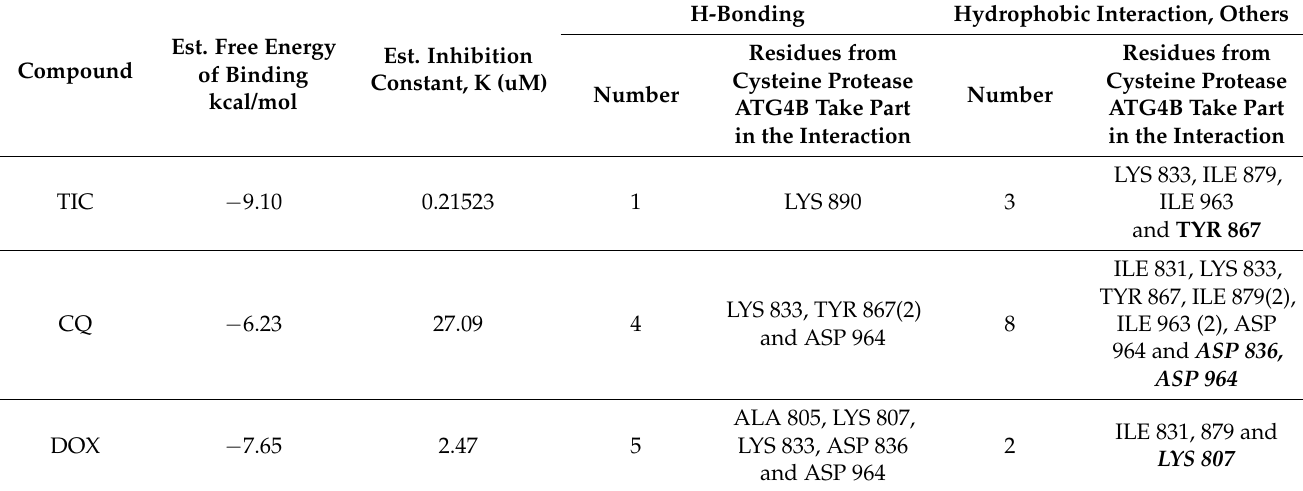
Table 3. Results of the docking of FDA-approved drugs and the interactions constructed on the crystal structure of PI3K γ (PDB ID: 1E8X).